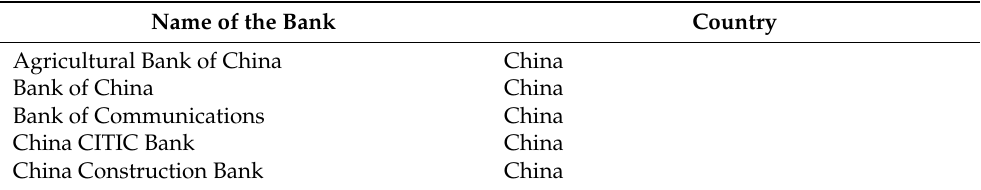
Table 1. Characteristics of selected